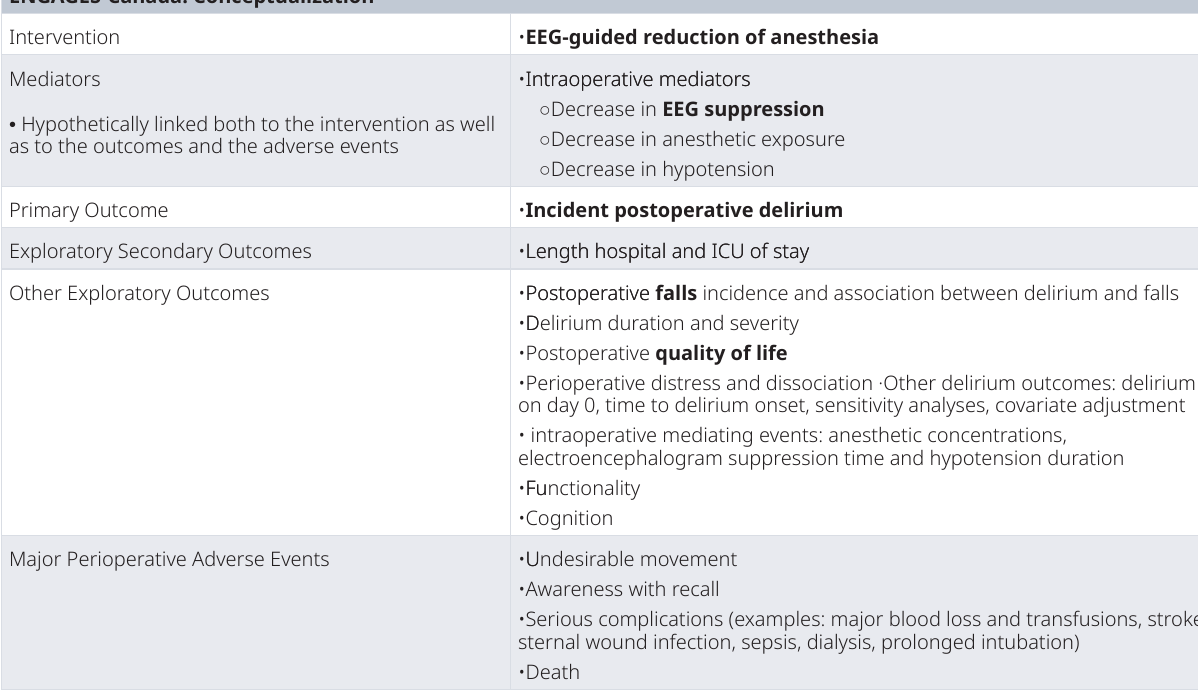
Table 1. ENGAGES-Canada: Conceptualization – Intervention, Mediators, Outcomes, and Adverse Events. Assessment acronyms: EEG – Electroencephalogram; ICU – Intensive Care Unit. ENGAGES-Canada: